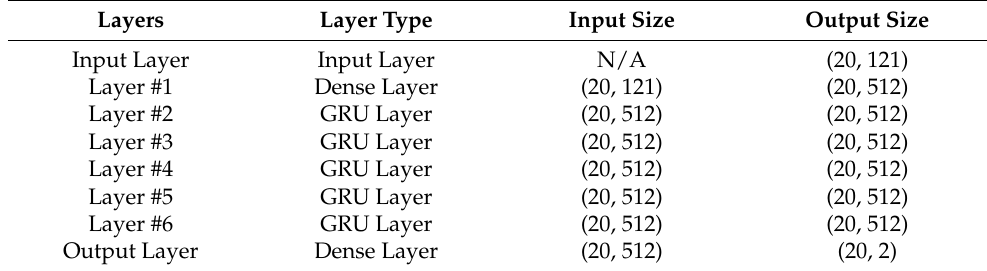
Figure 9. Deep GRU network architecture. Table 3. Detail Structure of Deep GRU